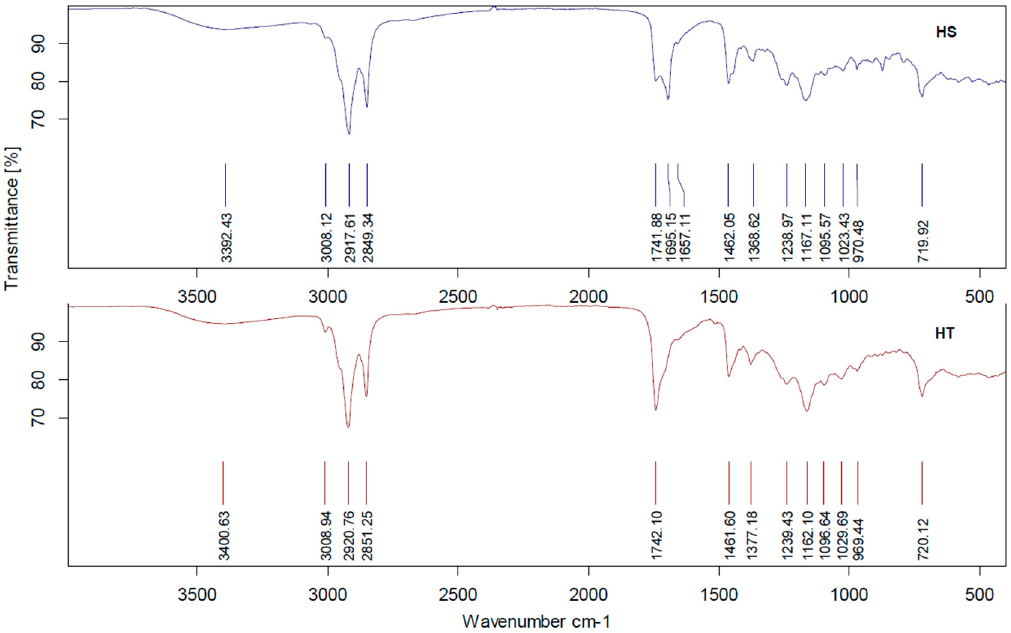
Figure 4. ATR–FTIR spectra of supercritical extracts obtained from H. salicifolius (HS) and H. tuberosus (HT) with water as a co-solvent (CO 2 + H 2 O extracts). Table 4. Major band assignments for the ATR–FTIR spectra of supercritical extracts obtained from H. salicifolius and H. tuberosus with water as a co-solvent (CO 2 + H 2 O extracts).